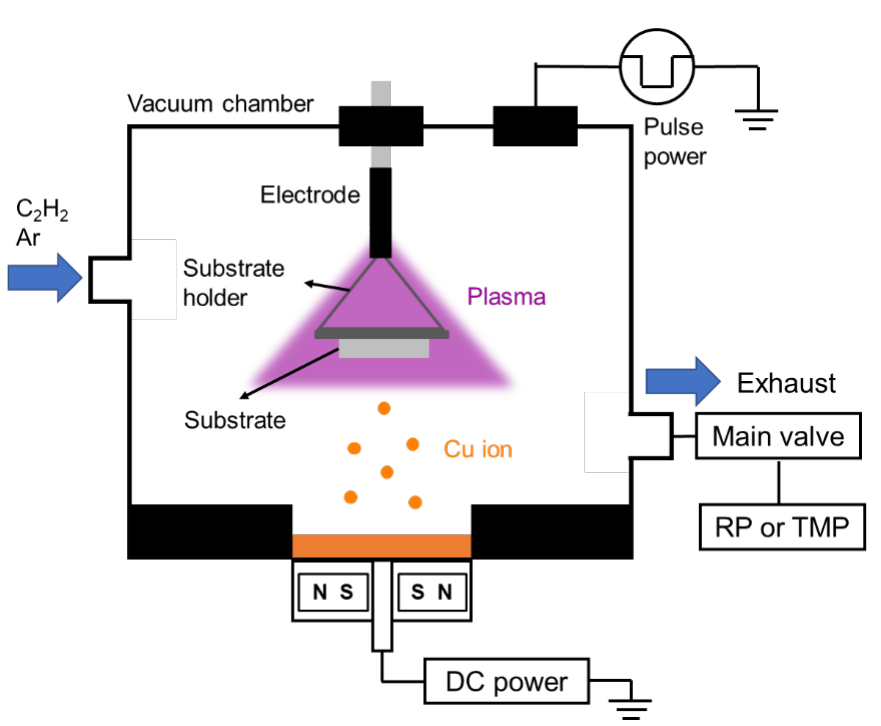
Figure 1. Schematic of the experimental setup. Table 1. Conditions of cleaning, deposition, and sputtering.